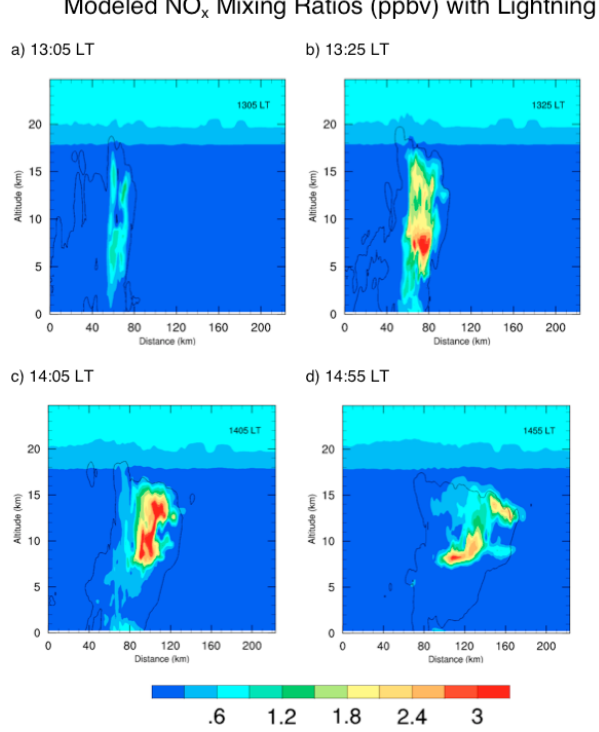
Fig. 12. Time series of vertical cross sections of NO x mixing ratios for simulations without lightning NO production at (a) 13:05LT, (b) 13:25LT, (c) 14:05LT, and (d) 14:55LT, oriented 130 ◦ from north through the storm core. The thin black line indicates the 0.01gkg − 1 total condensate contour.